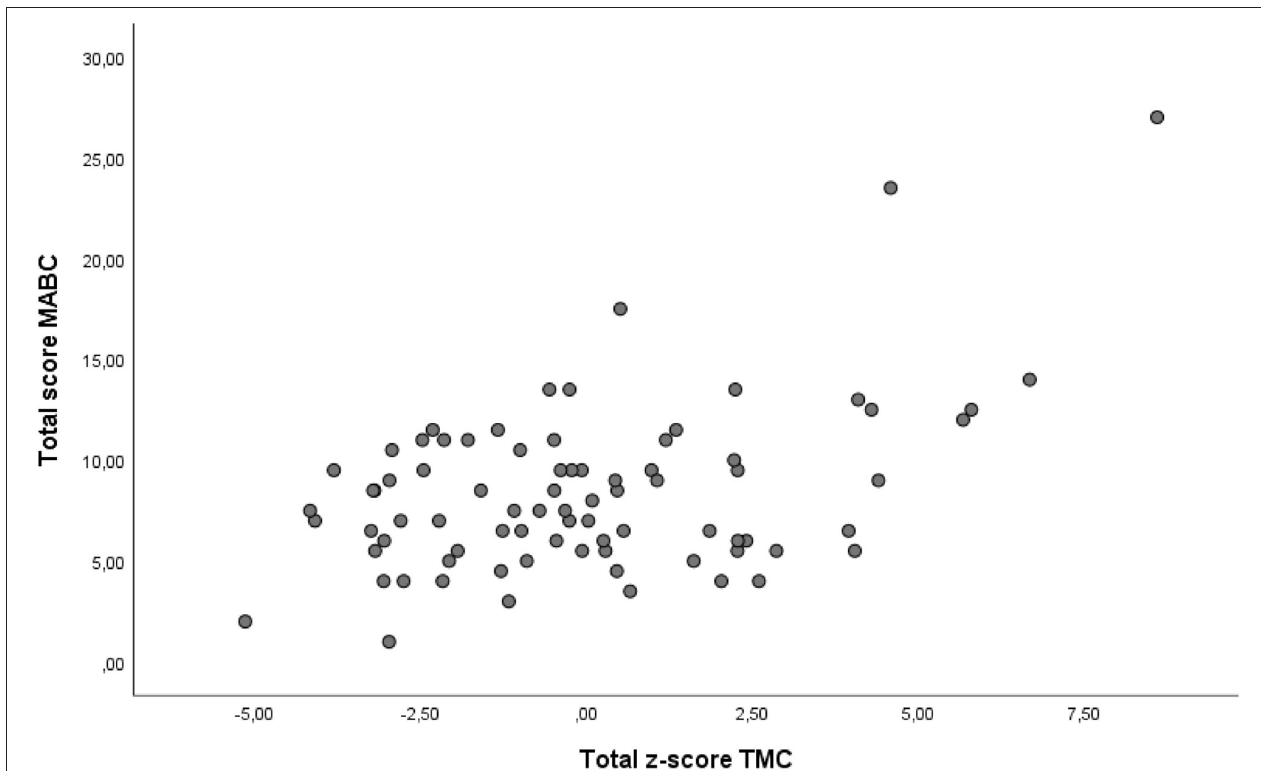
FIGURE 1 | Scatterplot of the relationship across individual children between total score MABC and total z-score TMC.